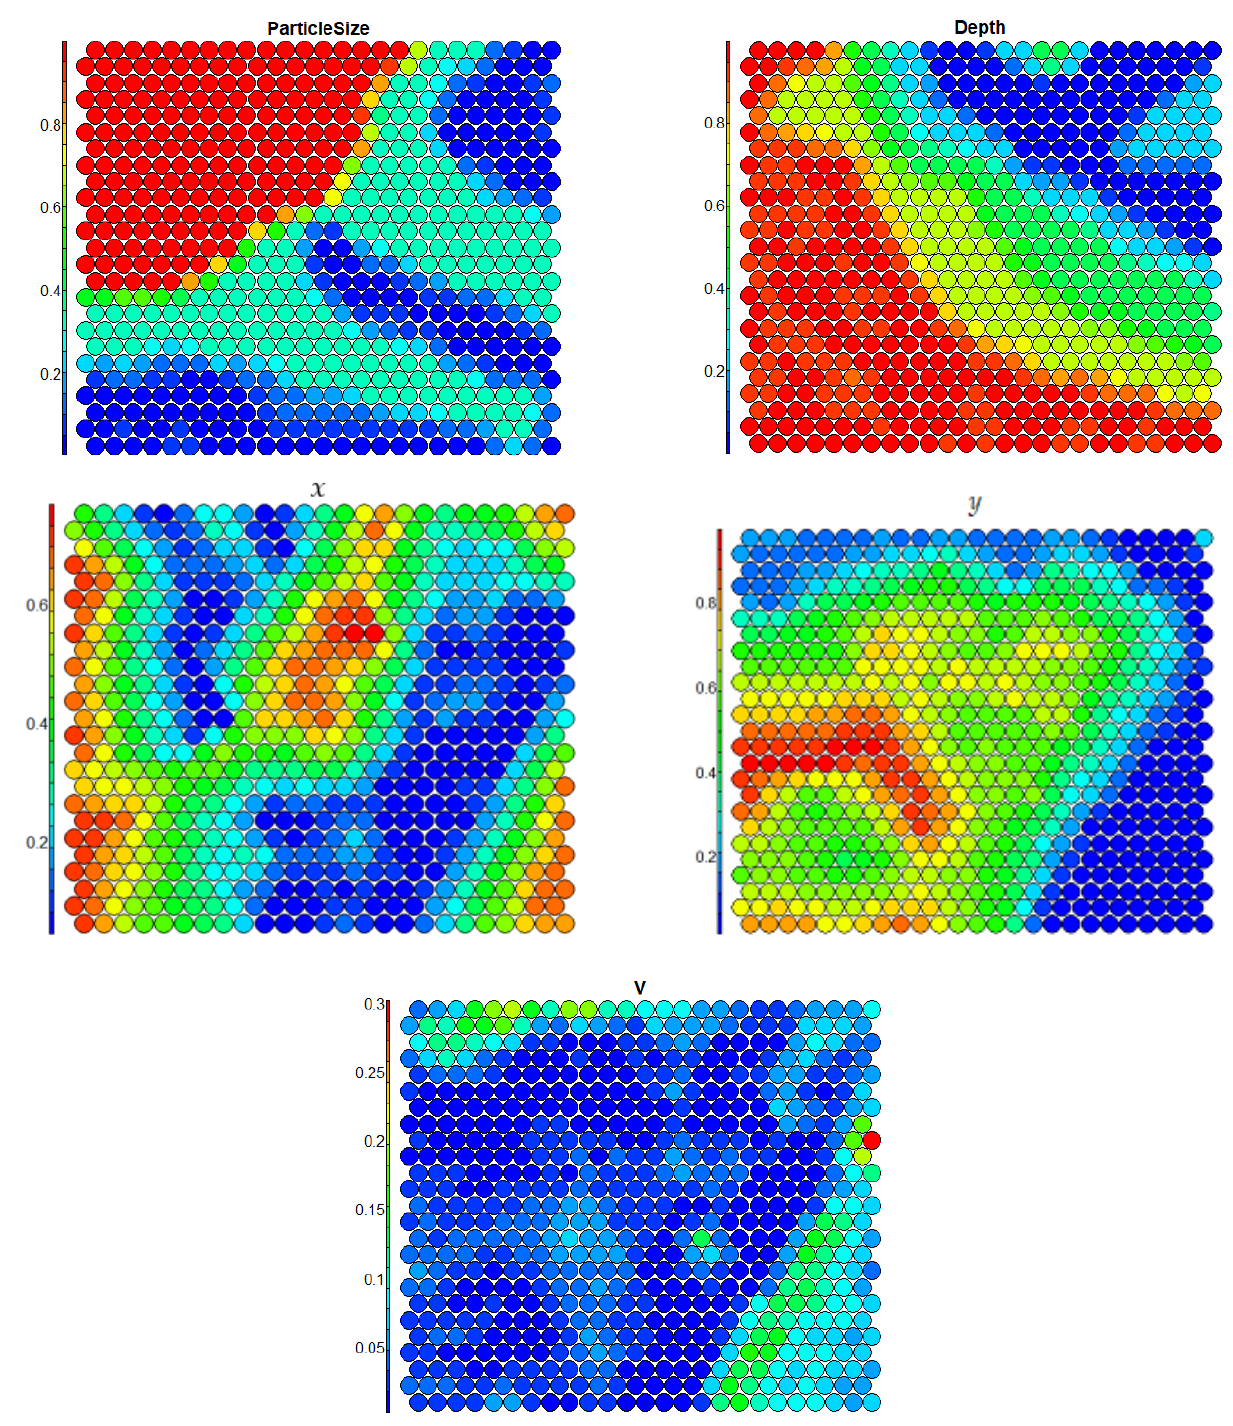
Figure 10. Heat maps of the 25 × 25 Kohonen map.